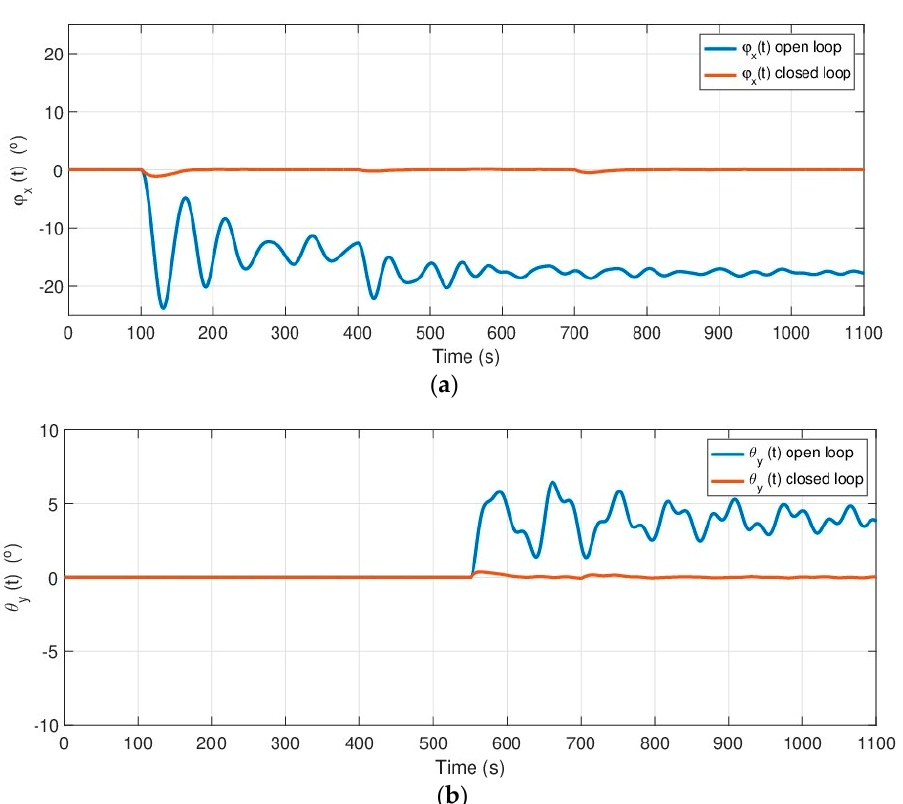
Figure 15. Open loop and closed loop time responses under step variations of wind magnitudes. ( a ) Open loop and closed loop responses for the 𝑥 -axis rotation. ( b ) Open loop and closed loop responses for the 𝑦 -axis rotation.